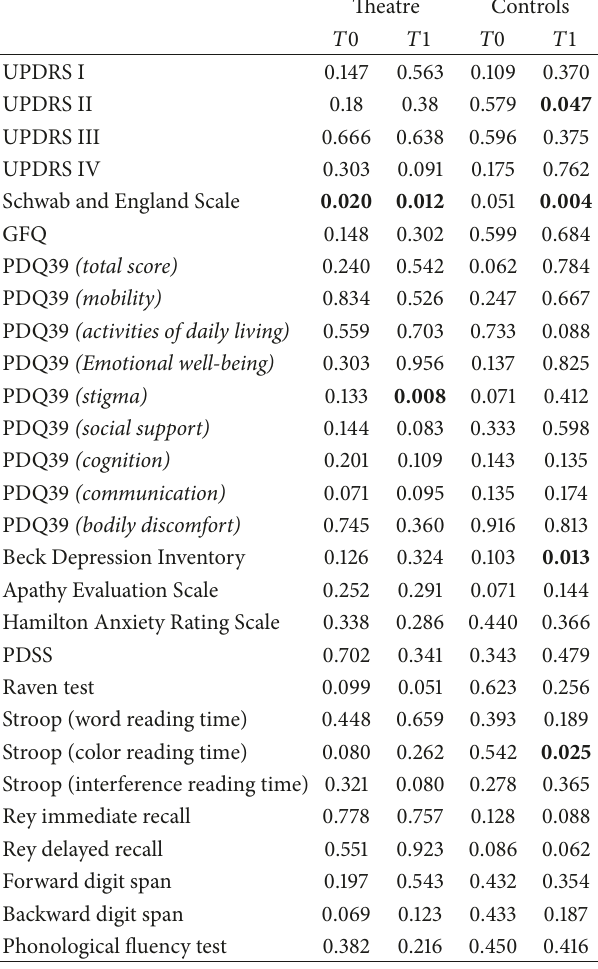
Table 3: 𝑝 values obtained from the Shapiro-Wilk test of normality for the two groups of PD patients (theatre group and control group) in all clinical scales and subscales at the beginning ( 𝑇0 ) and the end ( 𝑇1 ) of the rehabilitation treatments. 𝑝 values less than 0.05 indicate that the data are not from a normally distributed population and are indicated in bold. UPDRS:Unified Parkinson’s Disease Rating Scale; GFQ: Gait and Falls Questionnaire; PDQ39: Parkinson’s Disease Quality of Life Scale; PDSS: Parkinson’s Disease Sleep